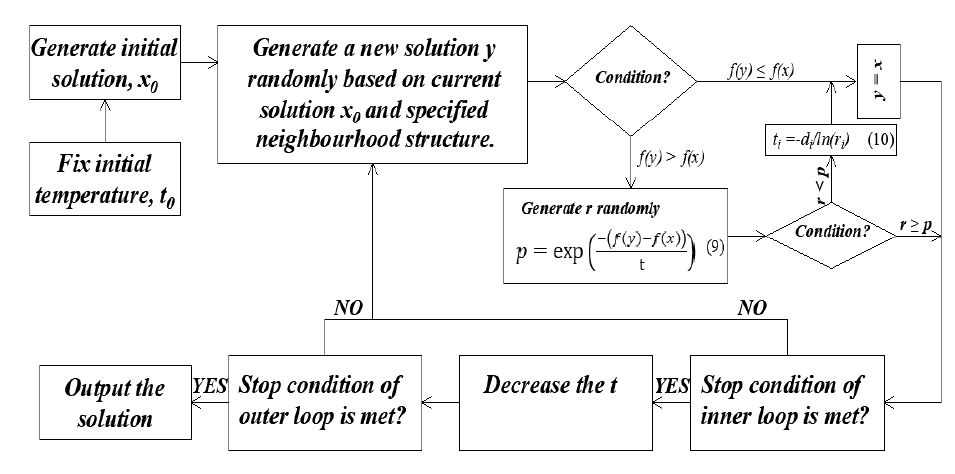
Fig. 5 . The flow chart of